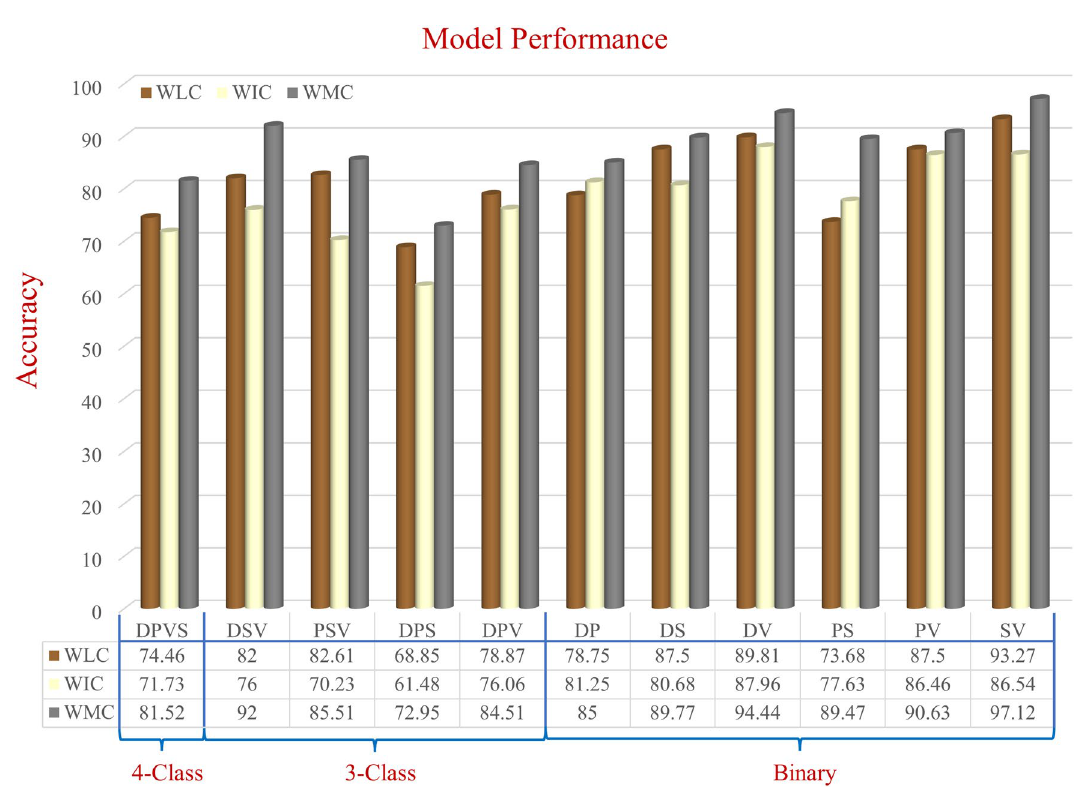
Figure 7. Performance comparison of wound-class classification among the best models from each category (location—WLC, image—WIC, and multimodality—WMC) on AZH